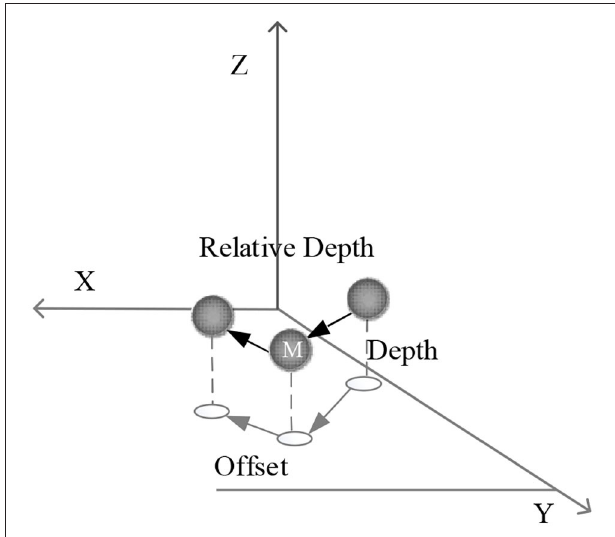
FIGURE 4 | Analysis of 3D joint points.